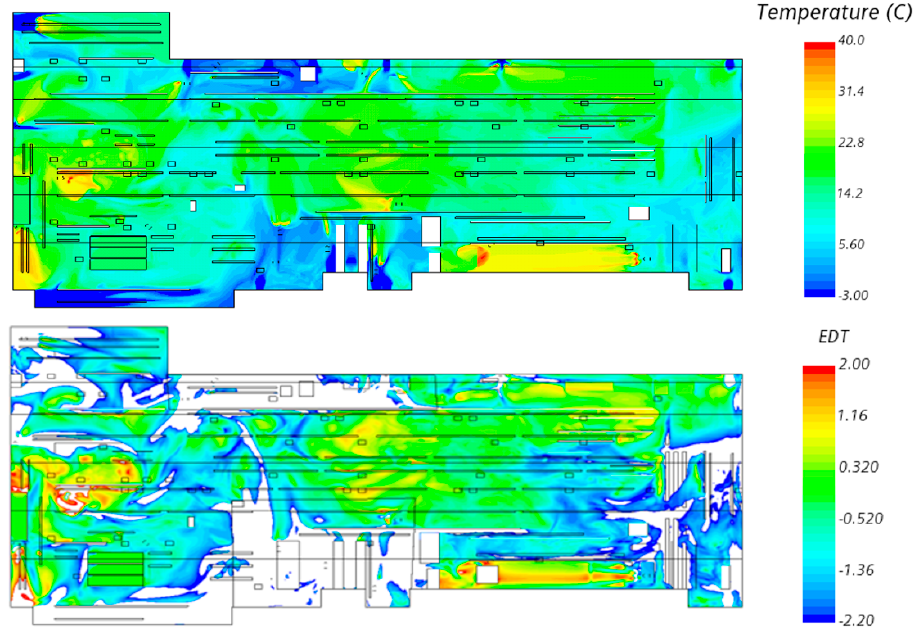
Figure 7. Temperature and EDT distribution in a large assembly factory under present heating conditions in winter assembly factory.